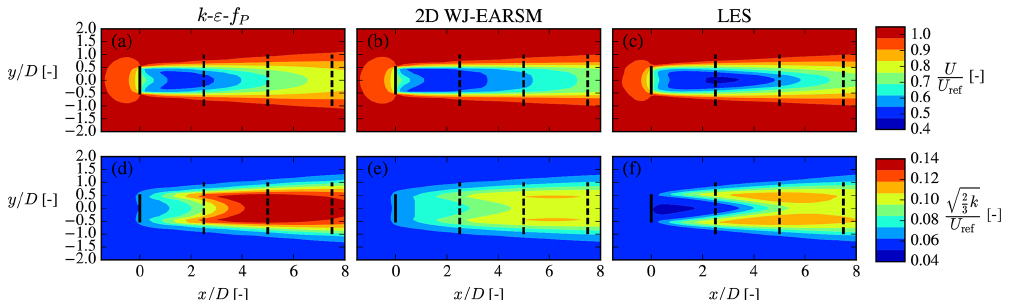
Figure 14. Streamwise velocity (a–c) and TI (d–f) contours at hub height for the single-wake V80 case. Full lines mark ADs, while dashed lines mark where wake profiles are